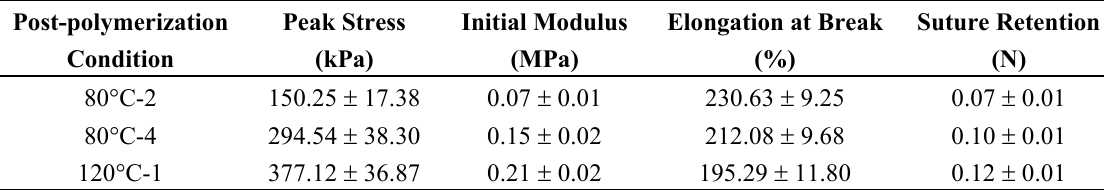
Table 1. Mechanical properties of single CUPE 1.2 scaffold sheets (thickness under different reaction conditions.